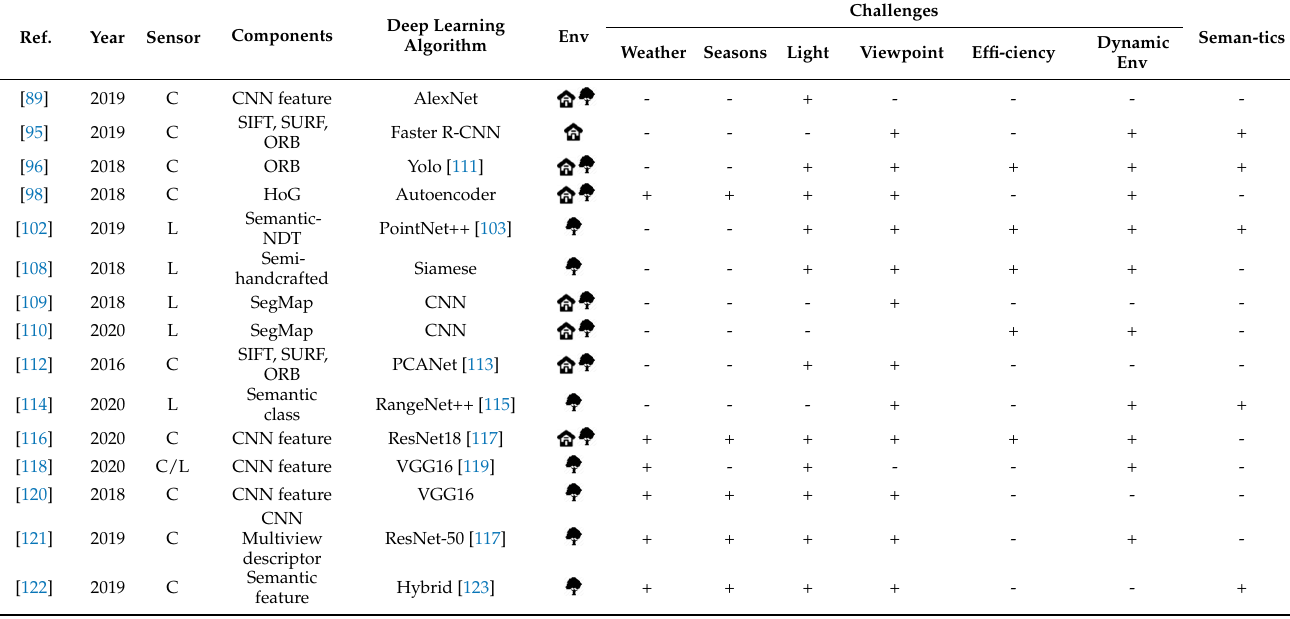
Table 2. State-of-the-art deep learning-based loop closure detection methods for visual and Lidar SLAM. Ref.